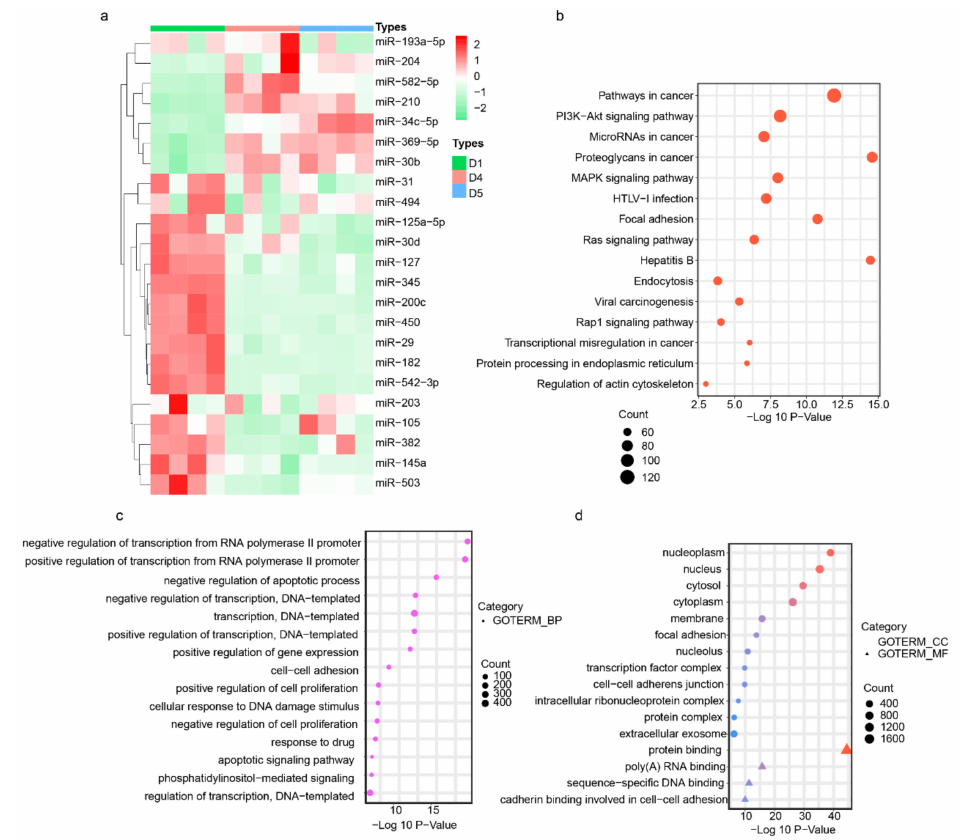
Figure 4. Endometrium-derived sEVs carry miRNAs which associated with uterine receptivity: ( a ) Heat map showed the expression profiles of miRNAs in sEVs derived from endometrium on D2, D4, and D5 of pregnancy. ( b – d ) GeneOntology GeneOntology (GO) and Kyoto Encyclopedia of Genes and Genomes (KEGG)terms of genes were potentially targeted by miRNAs in sEVs. ( b ) A bubble plot of KEGG pathways enriched. ( c ) A bubble plot of GOs (Biological Process) enriched. ( d ) A bubble plot of GOs (molecular function and cellular components)